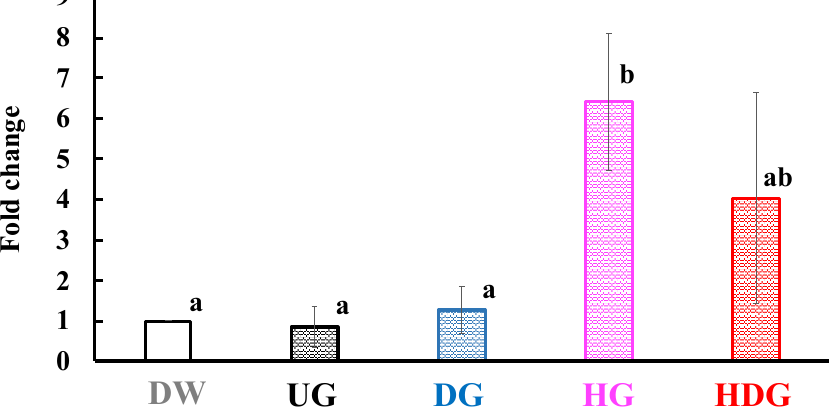
Figure 9. Mcpt8 mRNA expression level in the skin of mice after intraperitoneal challenge of gliadin followed by cutaneous sensitization with the corresponding gliadin. Values with different letters are significantly different at p < 0.05 based on the Tukey–Kramer test. Each value is the mean of eight experiments with SE shown as a vertical bar.